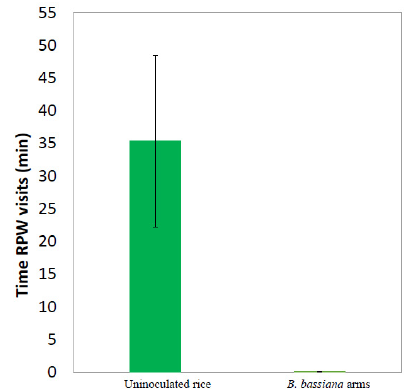
Figure 2. Mean time female RPW ( n = 3) visits in 60 min recording in Y-tube olfactometer between rice arm and B. bassiana arm.